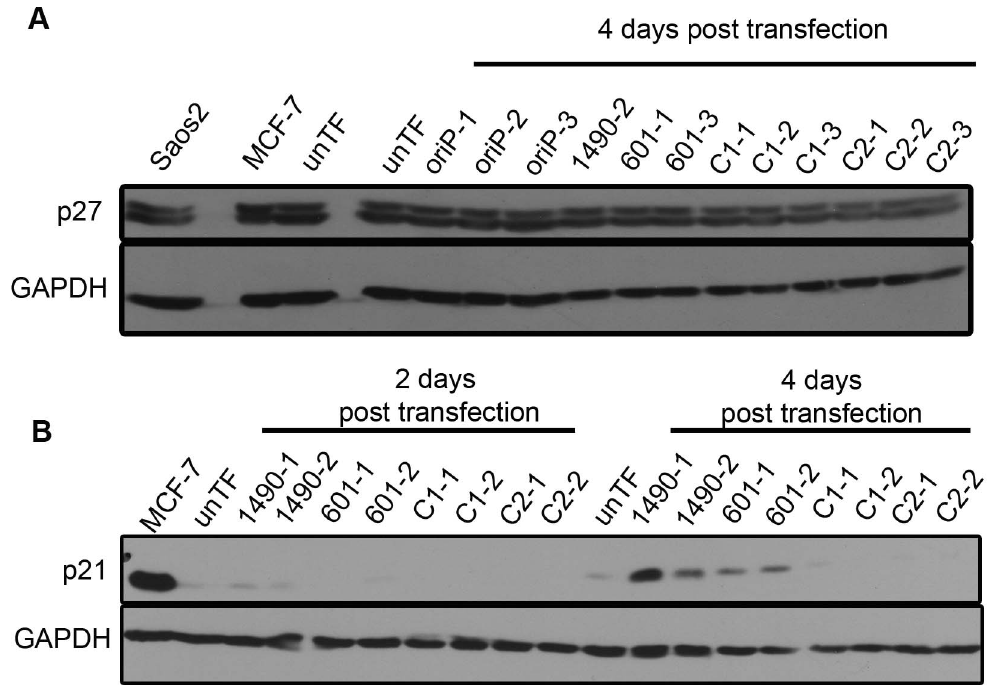
Figure 8. EBNA-3A represses p21 WAF1/CIP1 expression in Wp-R BL. Cell lysates from Sal BL cells transfected with the empty shRNA expression vector (oriP-GFP) or vector encoding EBNA-3A-specific (1490 and 601), or control (C1 or C2) shRNAs were analyzed by immunoblotting to detect (A) p27 at the onset of growth arrest (4 days post-transfection); and (B) p21 WAF1/CIP1 prior to and coincident with the onset of growth arrest at 2 and 4 days post- transfection, respectively. MCF7 and Saos2 lysates were used as positive controls; GAPDH served as a loading control. unTF, untransfected